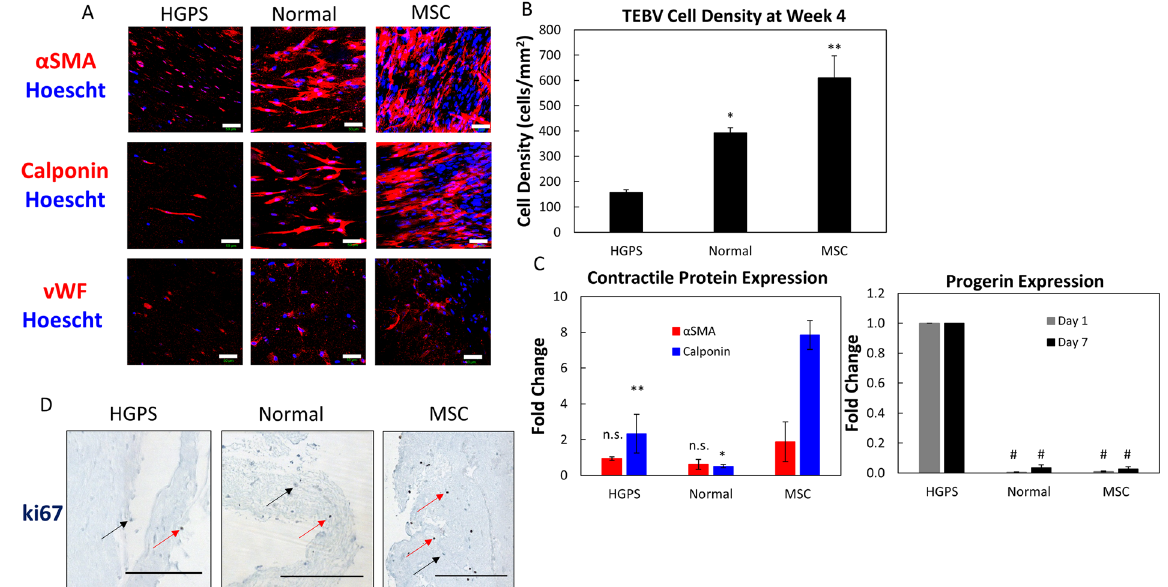
Figure 3. Structural characterization of TEBVs fabricated from MSC or iPSC-derived SMC TEBVs from healthy and Progeria patients. ( A ) Representative images of immunofluorescence staining with α -smooth muscle actin, calponin, and vWF antibodies at week 4 of perfusion on TEBVs fabricated from HGPS iSMCs, normal iSMCs, and MSCs and seeded with hCB-ECs in the lumen. (Scale bar, 50 μ m). ( B ) Quantification of cell density from A based on the number of nuclei per field area. ( C ) qRT-PCR of Progerin, alpha-smooth muscle actin and calponin gene expression on MSC, HGPS iSMC and normal iSMC TEBVs. Progerin expression was set at 100% for HGPS iSMC TEBV samples at day 1 and day 7. Alpha-smooth muscle actin and calponin gene expression in TEBVs at day 7 of perfusion culture were normalized to TEBVs on day 1 of perfusion culture. Data normalized to GAPDH expression. ( D ) Histochemical analysis of HGPS iSMC, normal iSMC, and MSC TEBVs at week 1 with ki67. Red arrows indicate ki67 positive cells and black arrows indicate ki67 negative cells (Scale bar, 200 μ m). n = 3 TEBVs for each TEBV cell type. * P < 0.05, ** P < 0.01, # P < 0.001, n.s. = not